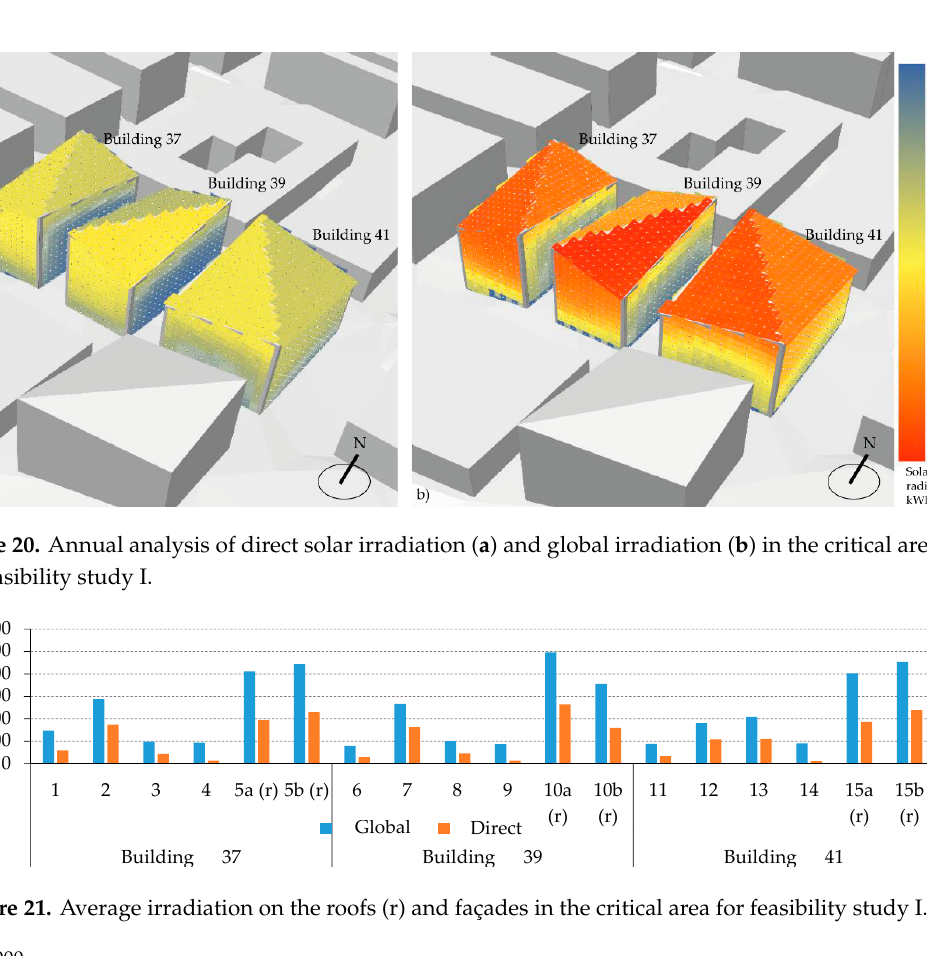
Figure 22. Solar energy generation on roofs (r) and façades in the critical area for feasibility study I.